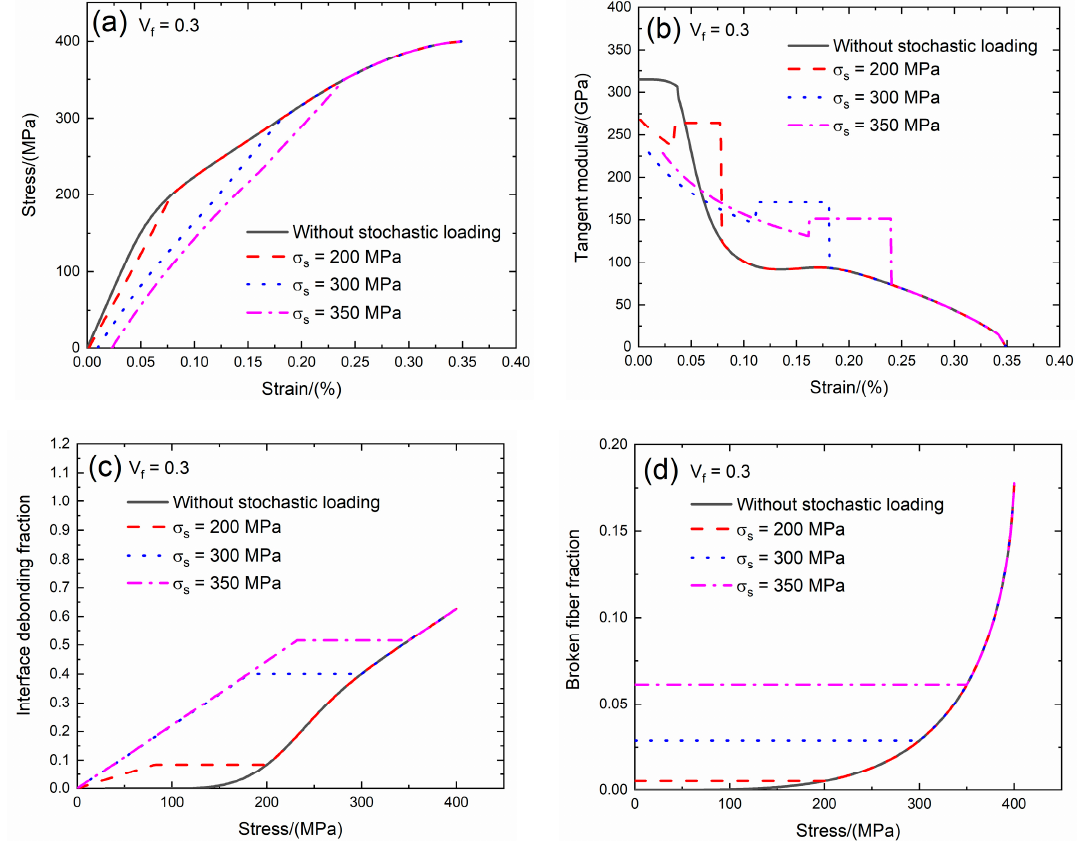
Figure 3. ( a ) The tensile stress–strain curves; ( b ) the tangent modulus versus strain curves; ( c ) the interface debonding fraction versus stress curves; and ( d ) the broken fibers fraction versus stress curves of SiC/SiC composite for conditions without stochastic loading and with stochastic loading of σ s = 200, 300 and 350 MPa when V f = 0.3.